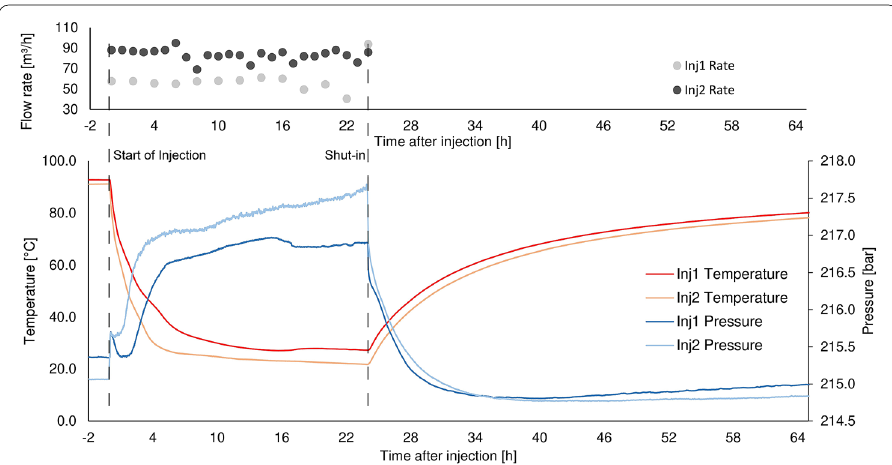
Fig. 4 P / T gauge data recorded during the first injection test of January 2020 (Inj1) and the second injection test of February 2020 (Inj2) with injection